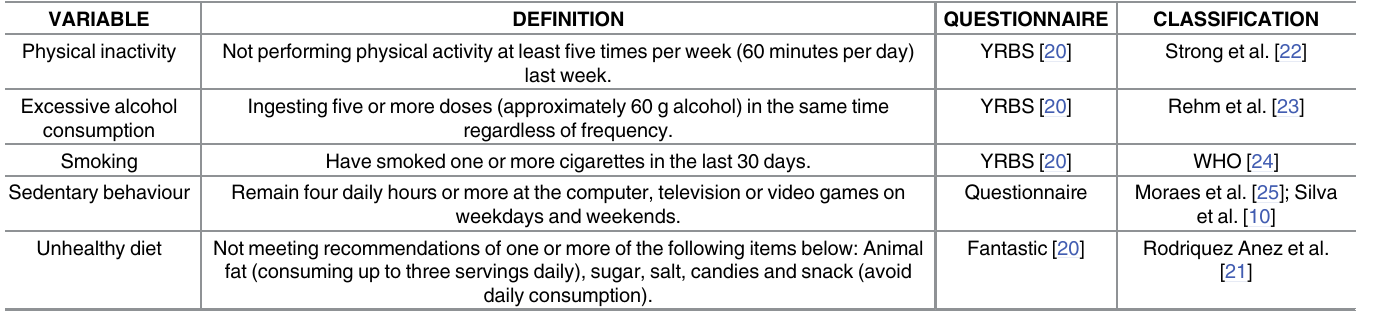
Table 1. Description and classification of dependent variables used in the